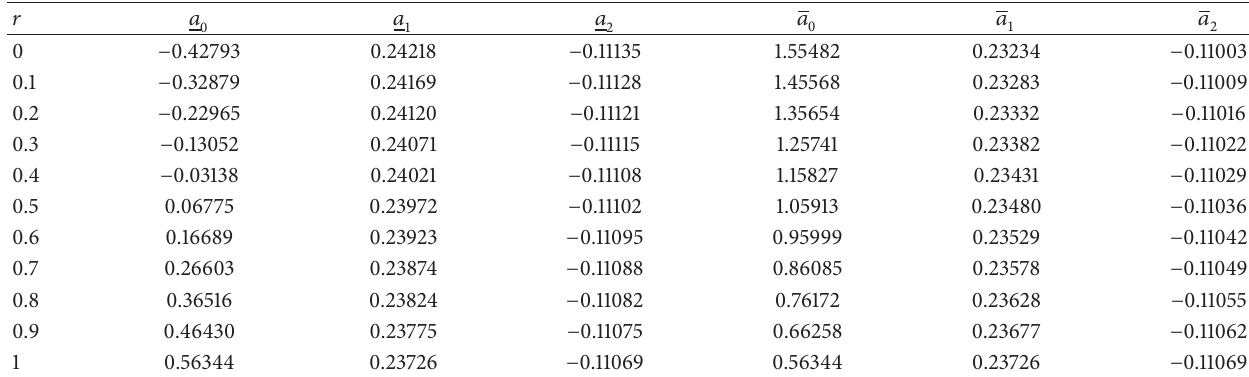
Table 2: The fuzzy coefficients for Case II with V = 0.75 , 𝛼 = 𝛽 = 0.5 , 𝑁 = 2 , and 𝑘 2 = 0.01386 .